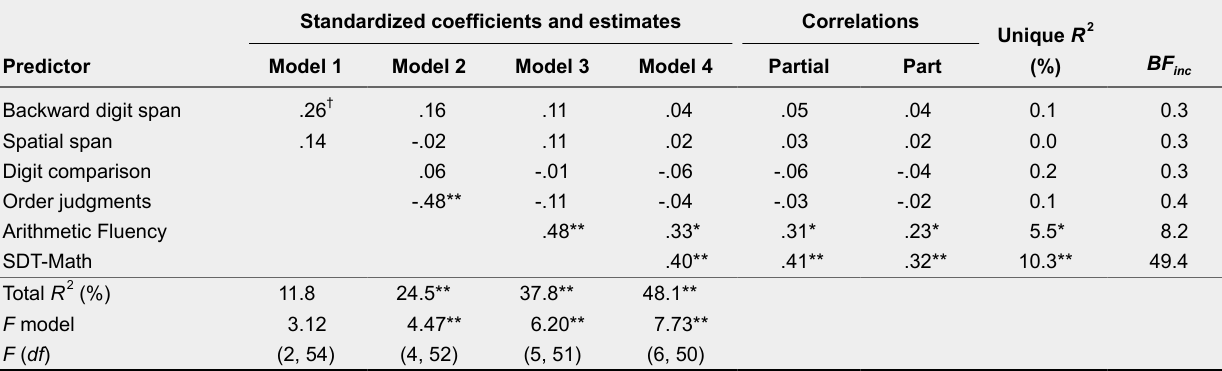
Regression Model for Fraction/Algebra Procedures Standardized coefficients and estimates Predictor